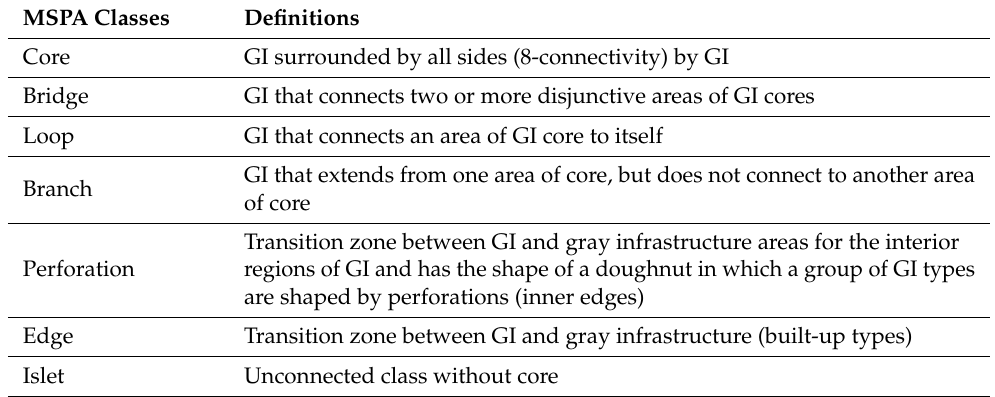
Table 1. Definition of morphological spatial patterns (source: Wang et al. [11,17]; adapted from Vogt